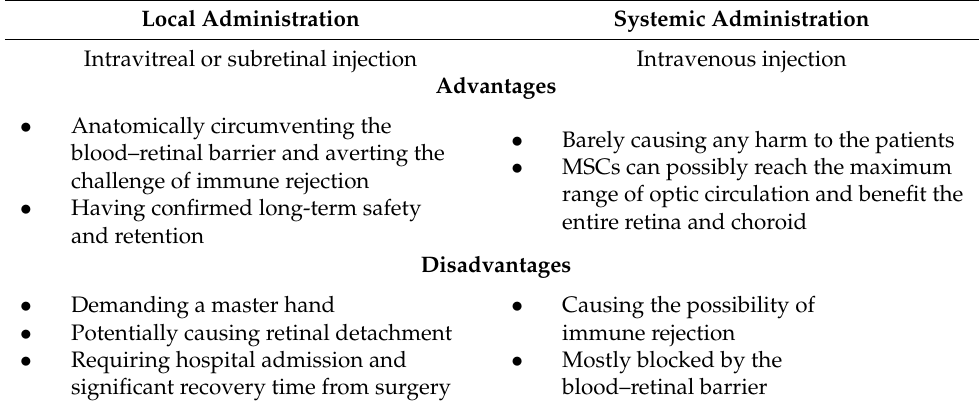
Table 2. The comparison of the delivery options in MSC-based treatment for retinal